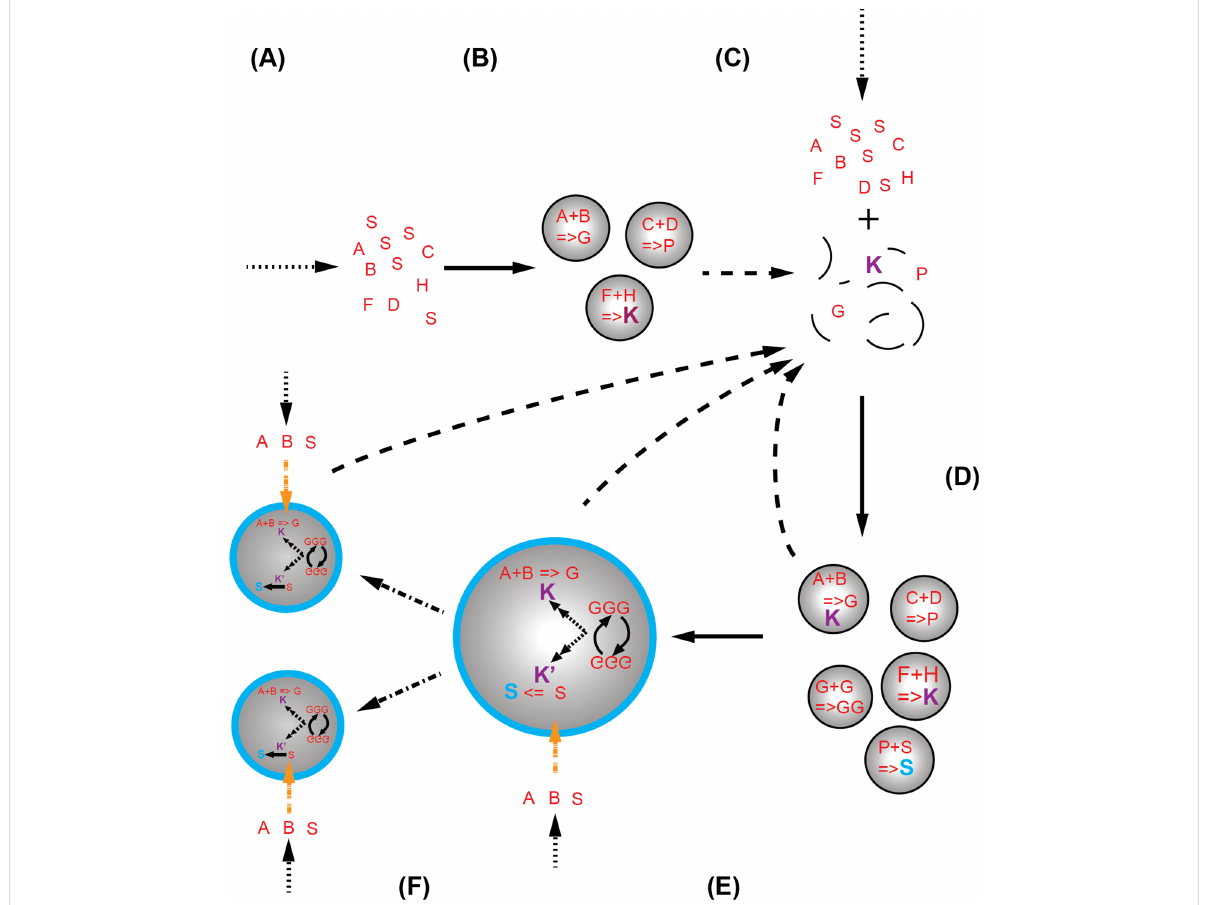
Figure 3: A putative scenario for the evolution of chemical systems towards protocells. (A) Prebiotic chemistry in the geochemical environment delivers an inventory of molecules (dotted arrow), some of which are amphiphiles (red S). When the aggregate critical concentration of the amphiphiles is reached, perhaps via trapping within a mineral pore structure, system compartments spontaneously form (plain arrow) and in the process co-locate chemicals, which could be either on the surface or within the system volume (B). The co-location allows a different chemistry (reac- tions are represented by letters with a “=>”) to take place as now both hydrophilic and hydrophobic environments contiguously co-exist. Upon subse- quent disruption of the compartments (C) due to chemico-physical fluctuations (pH value, ionic strength, pressure or temperature) the prebiotic molec- ular inventory (dashed arrow) is enriched in a new set of basic building blocks, some of which “K” might be catalysts for the syntheses of building blocks of the system. Once the environmental conditions become again conducive to self-assembly, new chemical systems form (D). Some of them will have capability to produce further chemical complexity (new products or catalysed reactions). Cycles of formation/disruption will occur until (E) system compartments with improved stability (here highlighted by the blue boundaries composed of blue S, i.e., new amphiphiles) appear. These compartments will then gradually increase their internal catalytic network (dotted–dashed arrow) and gain some element of information processing capability, thus forming primitive protocells (Figure 1B). At that stage, they might still require chemical input from the environment (orange dotted arrow). However, they likely only take up certain chemicals selectively due to boundary permeability. These systems with increased half-life will perhaps also be disrupted cyclically until they are capable to self-replicate and adapt to environmental fluctuations (F). Once stable over long time periods, these systems would be clearly the first complete embodiment of a protocell (Figure 1B). Plain arrows relate to a self-assembly process, dotted arrows the prebiotic synthesis of chemicals, dashed arrows the disruption of a chemical system, the orange dashed arrows the selective permeability towards chemicals of the chemical system boundaries and the dotted–dashed arrows the replication